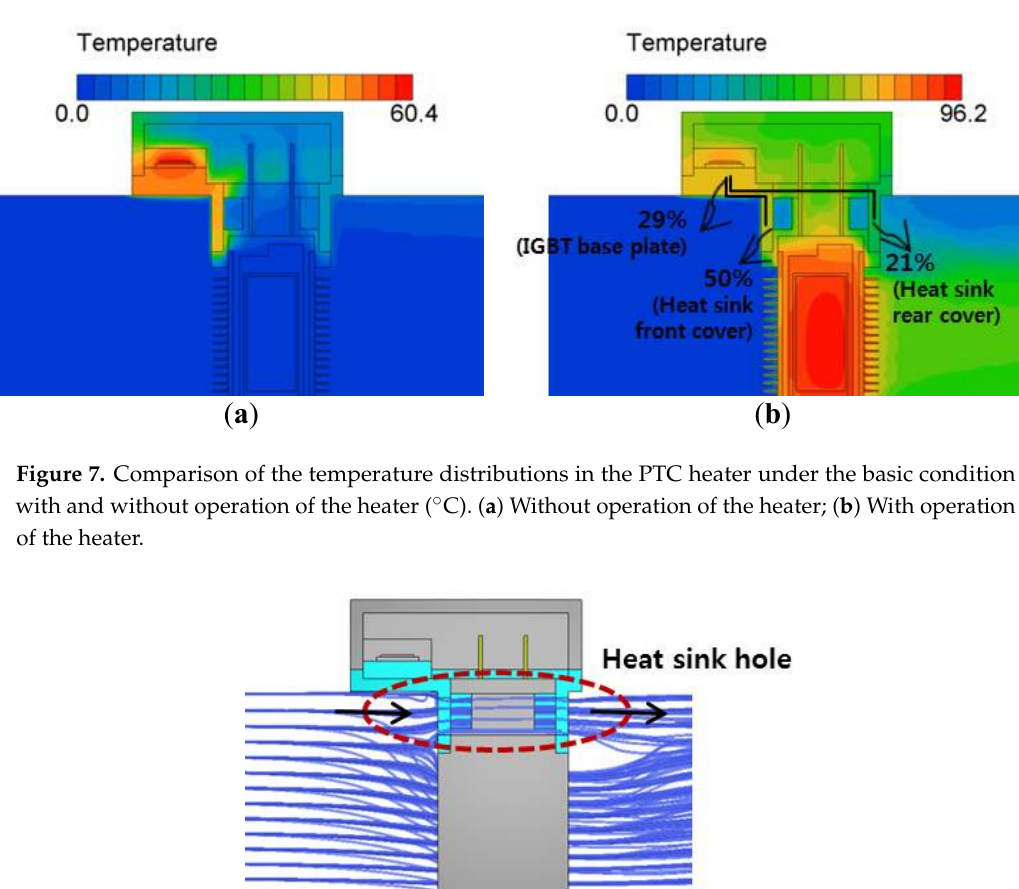
Table 6. Results of the heat flow analysis of the controller-integrated high-voltage PTC heating system.